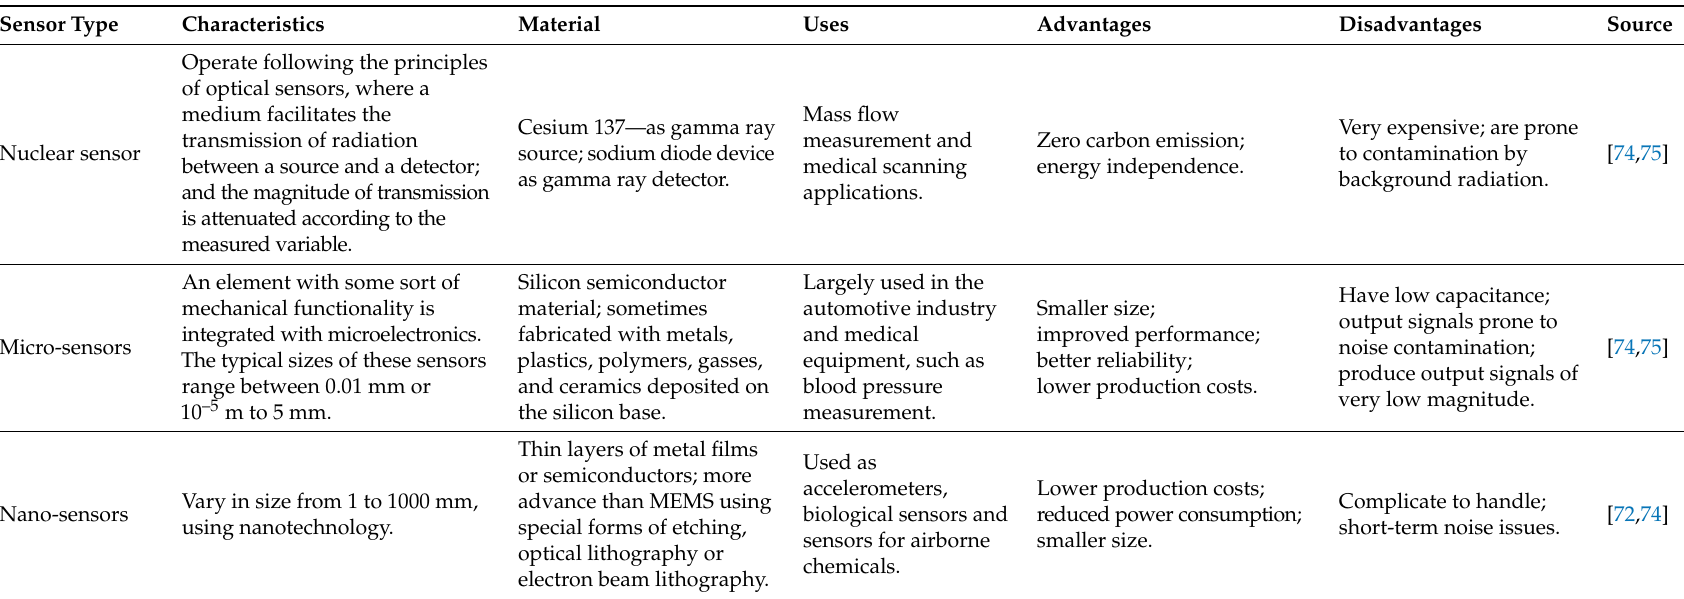
Table 7. Key features of nuclear, micro, and nano